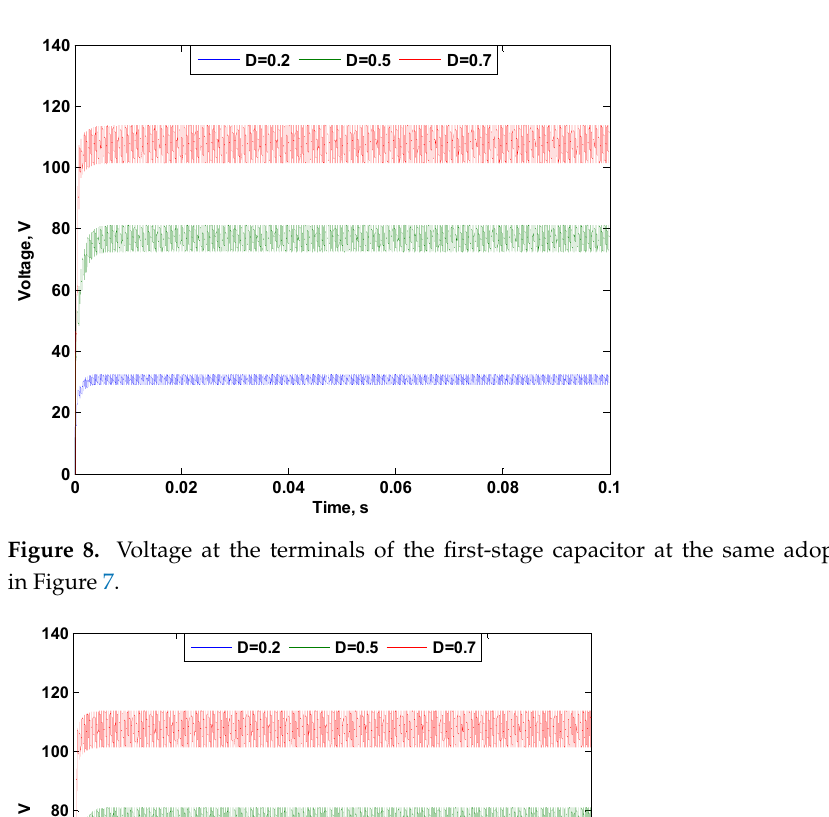
Figure 7. Output voltage at the output terminals of the studied converter at different duty ratios.